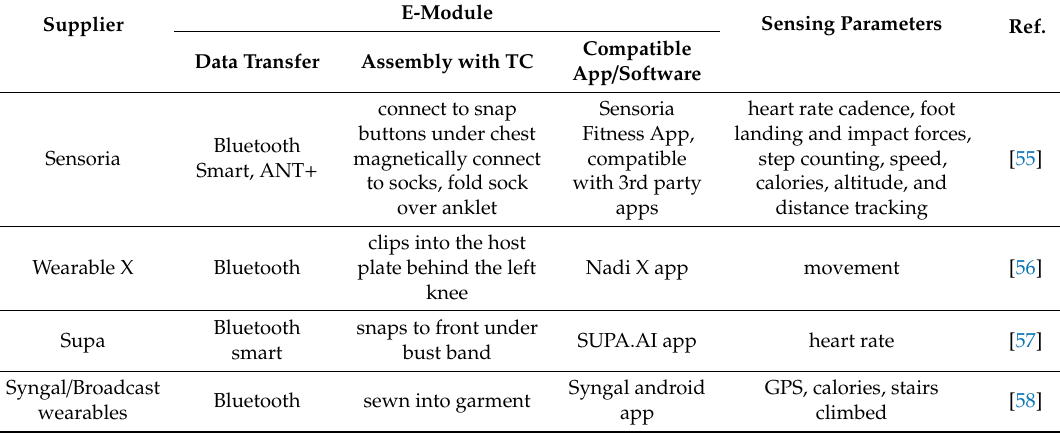
Table 7. Features of the electronics modules of available SeCSs for fitness